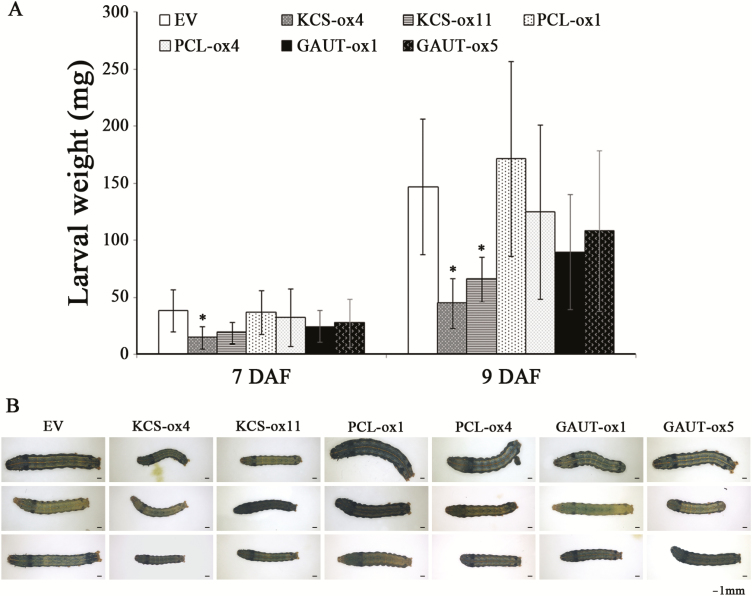
Insect resistance of IbKCS-overexpressing, IbPCL-overexpressing, and IbGAUT-overexpressing tobacco plants. (A) Body weights of the second-instar larvae were measured at the indicated time after larvae were fed the leaves from transgenic tobacco with empty vector (EV), and overexpressing IbKCS (KCS-ox4 and KCS-ox11), overexpressing IbPCL (PCL-ox1 and PCL-ox4), and overexpressing IbGAUT (GAUT-ox1 and GAUT-ox5). (B) Representative images of the larvae fed EV, KCS-ox, PCL-ox, and GAUT-ox tobacco leaves after 9 d. Data are presented as means ±SD (n≥8). The asterisks represent a significant difference between EV and overexpressing tobacco plants by Student’s t-test (*P<0.05).